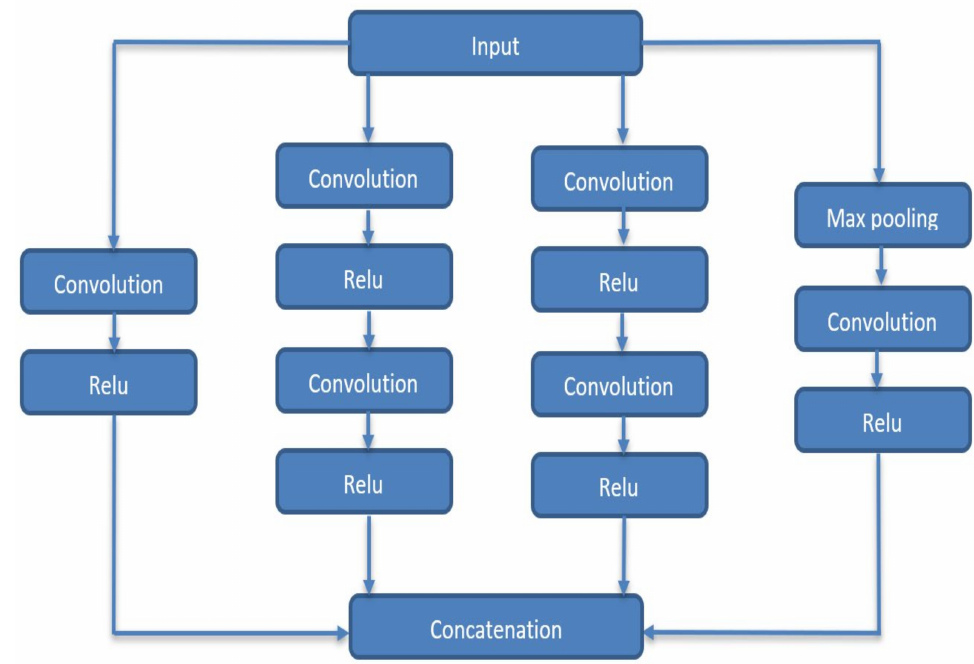
Figure 3. Inception module in GoogleNet.